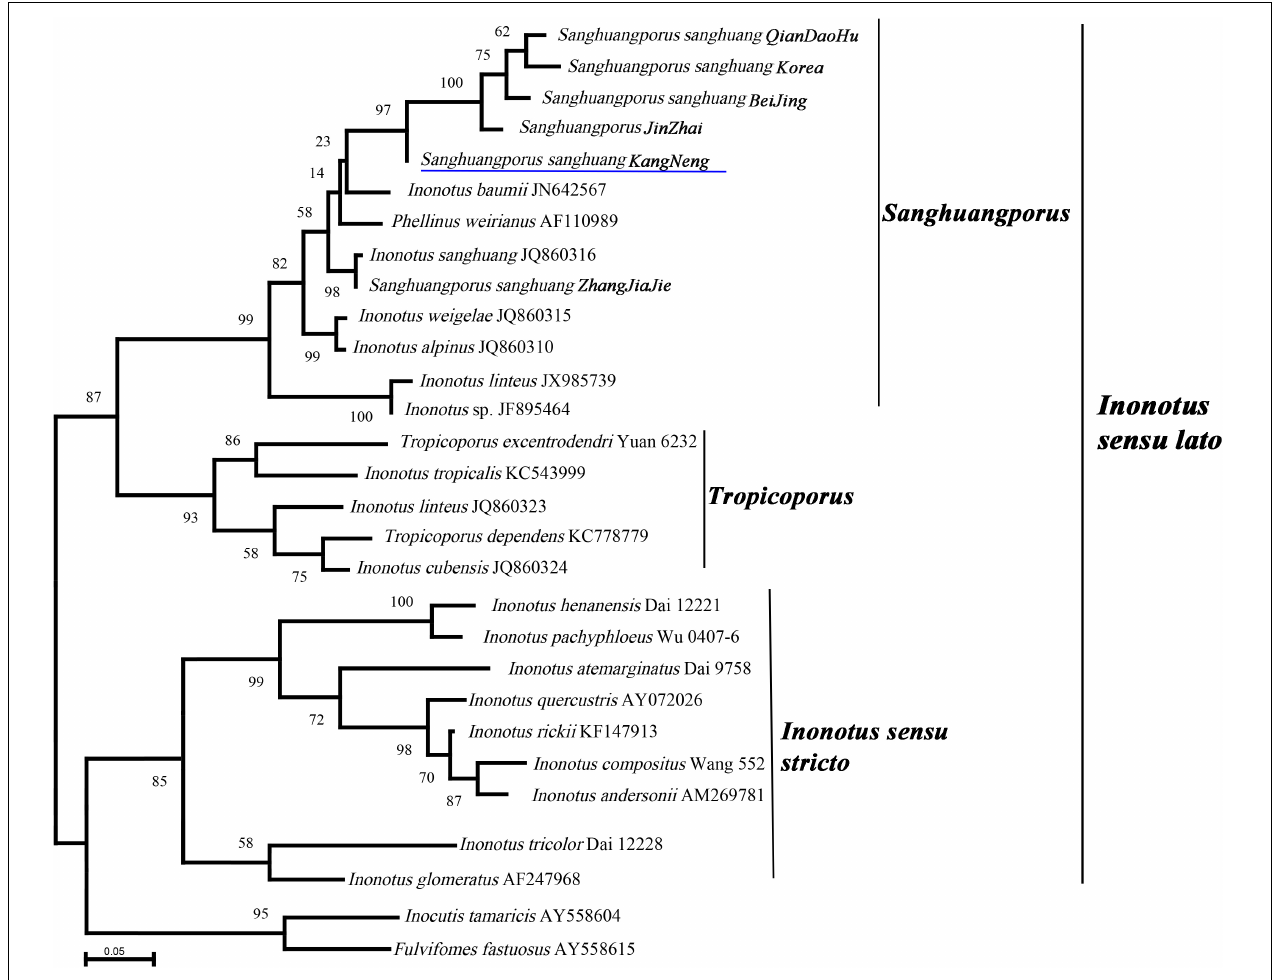
FIGURE 1 | Phylogeny of Sanghuangporus sanghuang strains and selected representative fungi inferred from ITS sequences. Bootstrap values from maximum likelihood analysis. The newly generated sequences for this study have been submitted to GenBank with accession numbers (MN242716–MN242721). The underlined species name was genome-sequenced in this